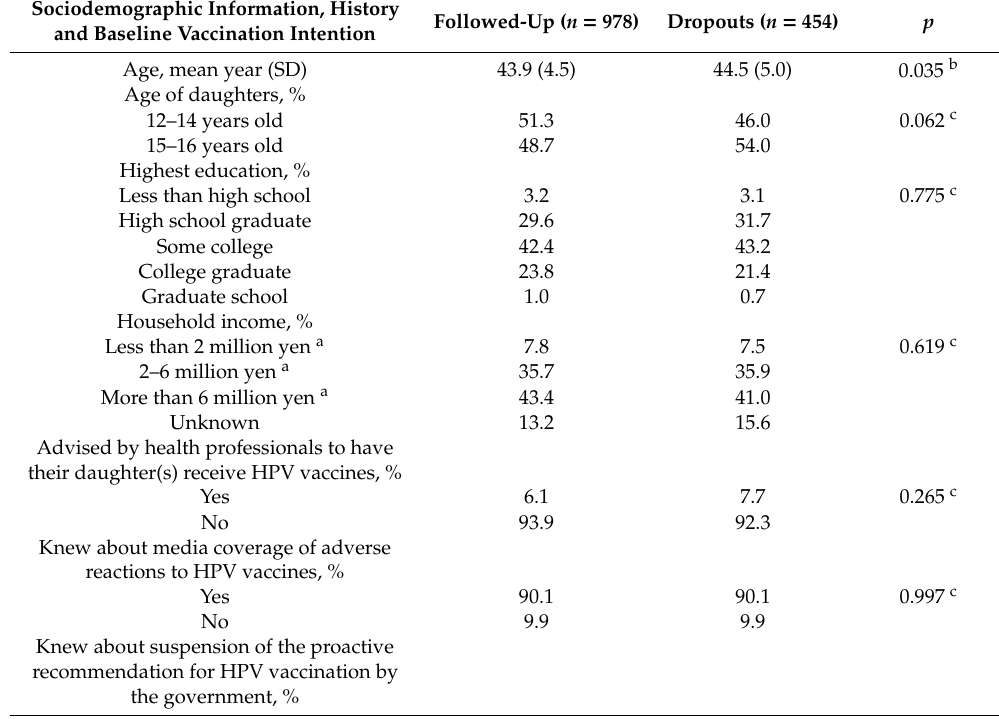
Table A1. Comparison between followed-up participants and dropouts. Sociodemographic Information, History and Baseline Vaccination